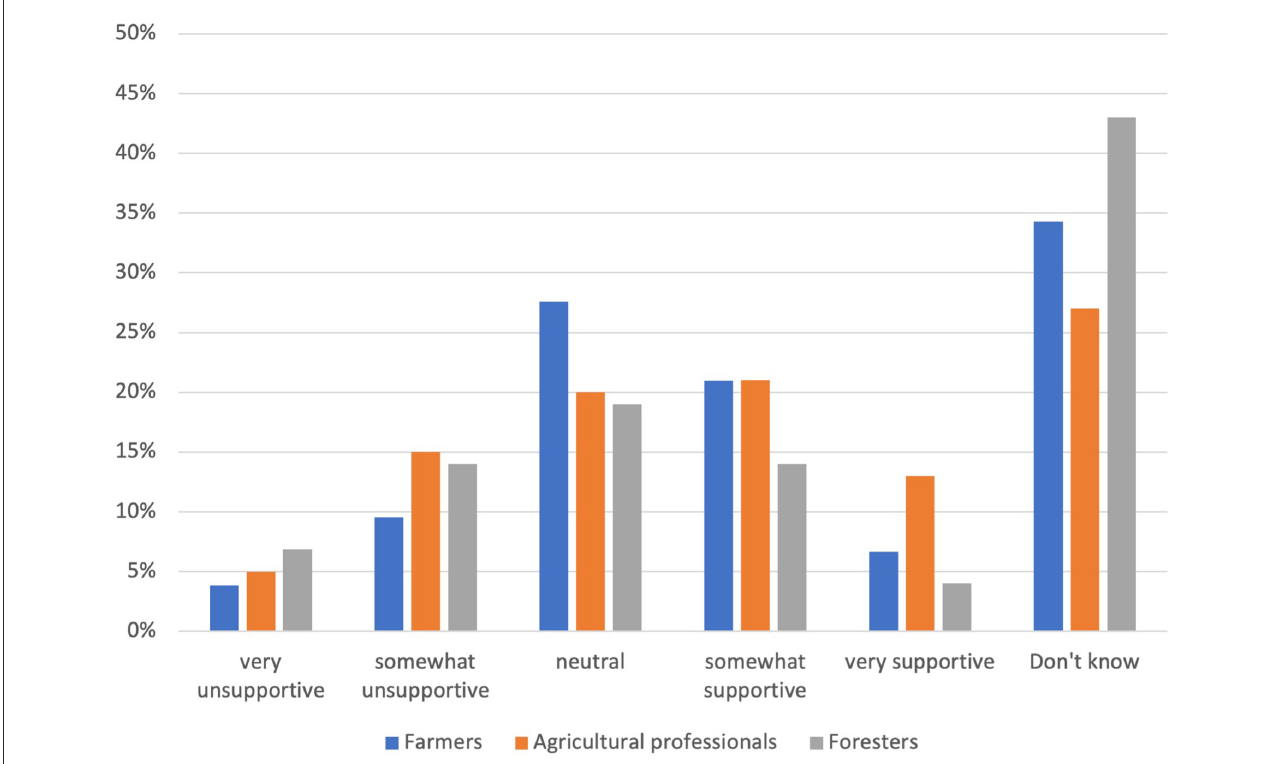
FIGURE2 Aggregated end of program workshop evaluation responses, 2014–2019, in Wisconsin and Minnesota, USA, to the question “Thinking about the past year, how supportive or unsupportive are professionals and farmers in your county toward silvopasture?” N =